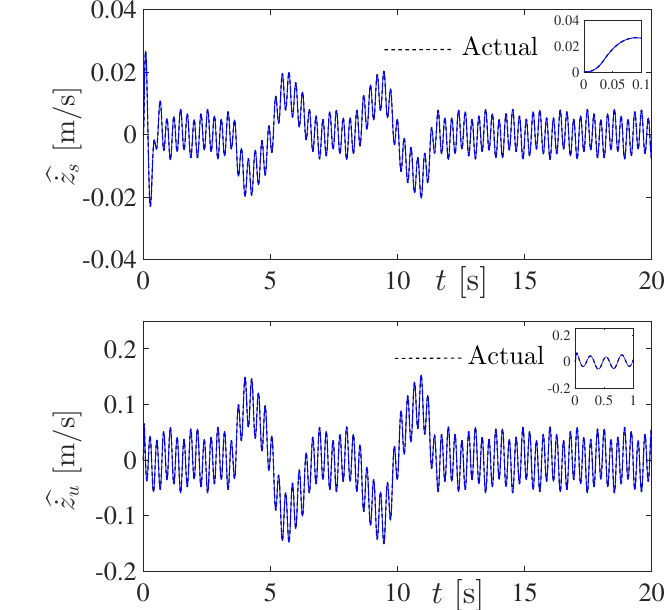
Figure 9. Online estimation of velocity signals.